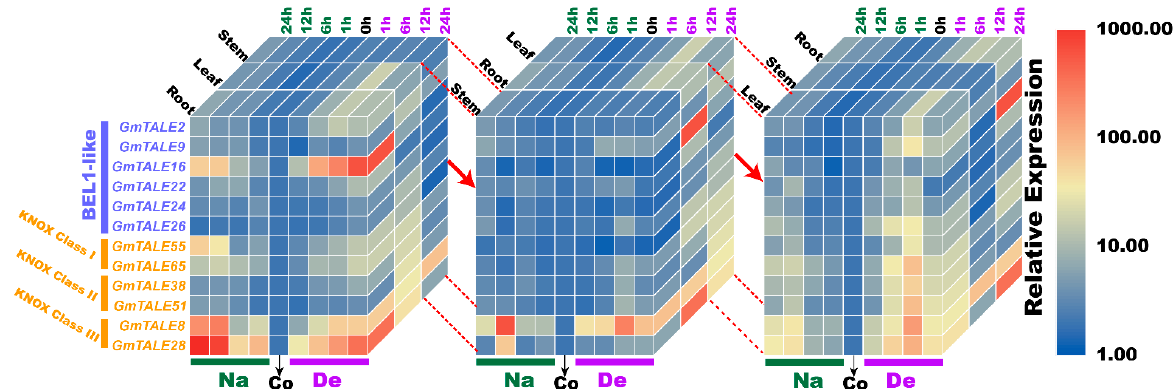
Figure 10. Quantitative RT-PCR analyses of the selected representative GmTALE genes in the KNOX subfamily during stress treatments throughout leaf, stem and root tissues. Data were normalized to the GmActin gene, and vertical bars indicated the standard deviations. The values represented the mean ± standard deviation (SD) of three independent rep- licates. Asterisks indicate the corresponding gene significantly up- or down-regulated compared with the 0-h statuses (* p < 0.05, ** p < 0.01, Student’s t -test). Na: saline stress; De: dehydration.